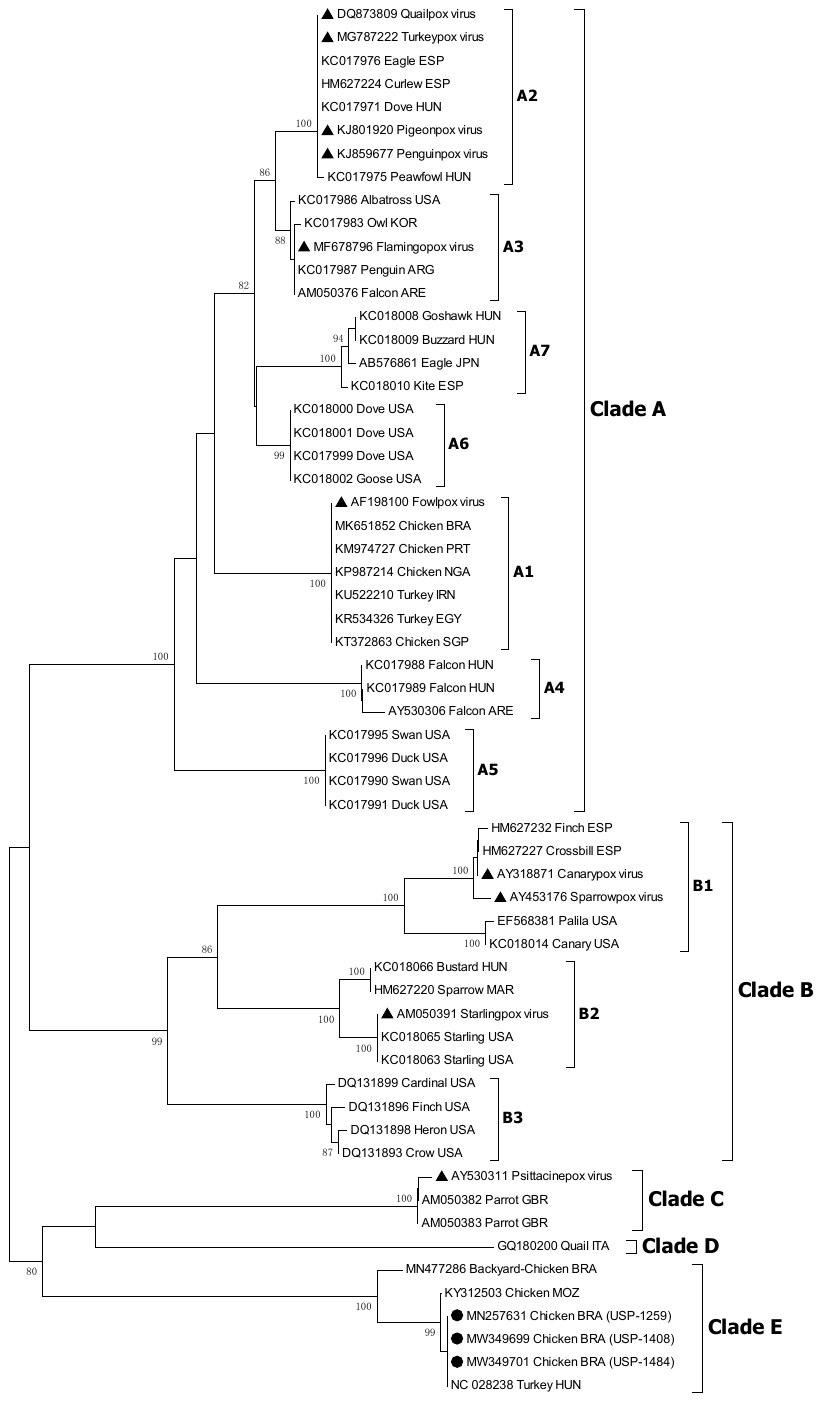
Figure 9. Phylogenetic analysis of partial major core ( P4b ) gene of APV strains. Strain names and GenBank accession numbers are shown. The black circles represent field APV strains of this study. Phylogenetic trees were constructed in MEGA v7.0 using the neighbor-joining method with 1000 bootstrap replicates. The evolutionary distances were computed using the Tamura 3-parameter model (T92 + I). Node values represent percentage support and scale bar represents the number of base substitutions per site. Brazilian strains of this study are represented by filled circles. Species representatives are shown with filled triangles.